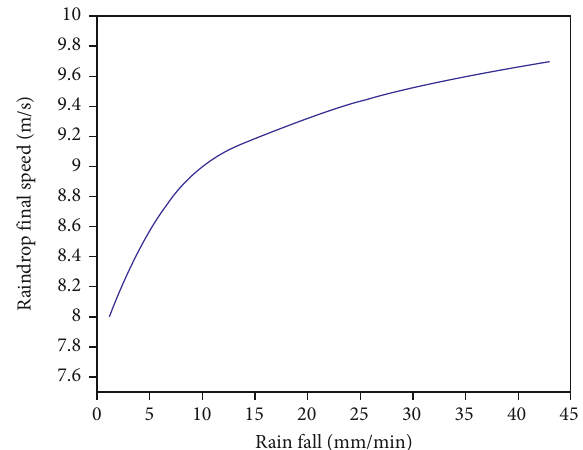
Figure 4: Relationship between precipitation and raindrop speed.